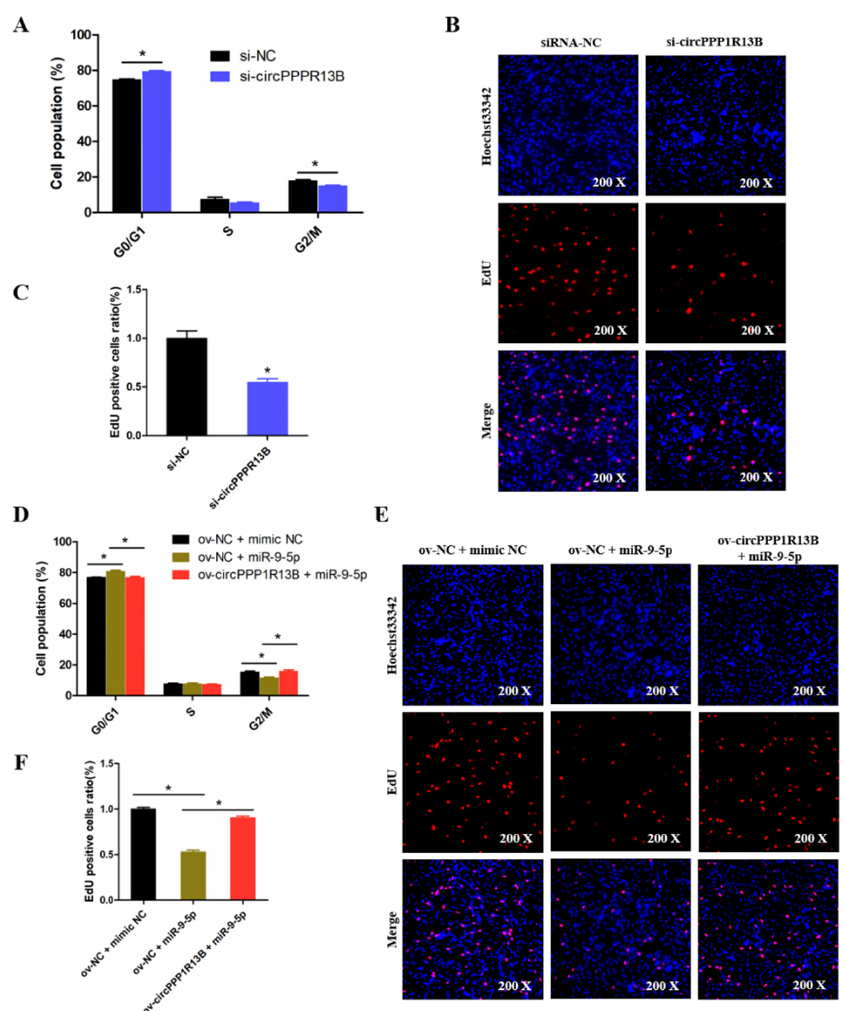
Figure 4. CircPPP1R13B regulates chicken SMSCs proliferation by targeting miR-9-5p. ( A ) Cell cycle analysis of SMSCs following circPPP1R13B knockdown. ( B ) EdU analysis plot of SMSCs following circPPP1R13B knockdown. ( C ) Relative EdU positive cells following circPPP1R13B knockdown. ( D )